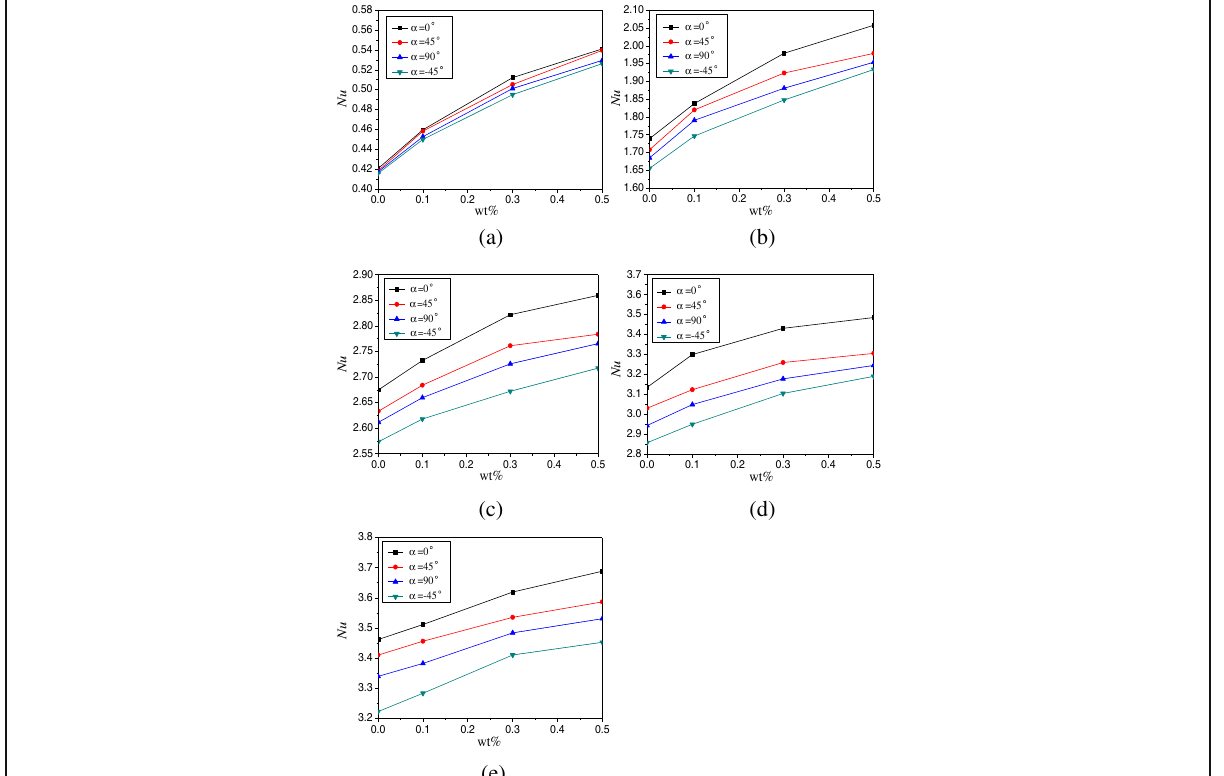
Fig. 9 Changes of Nusselt numbers with nanoparticle mass fractions ( A = 1:2). Average Nusselt numbers changes of nanofluid in the enclosure ( A = 1:2) with nanoparticle mass fractions at different heating powers. a Q = 1 W. b Q = 5 W. c Q = 10 W. d Q = 15 W. e Q = 20